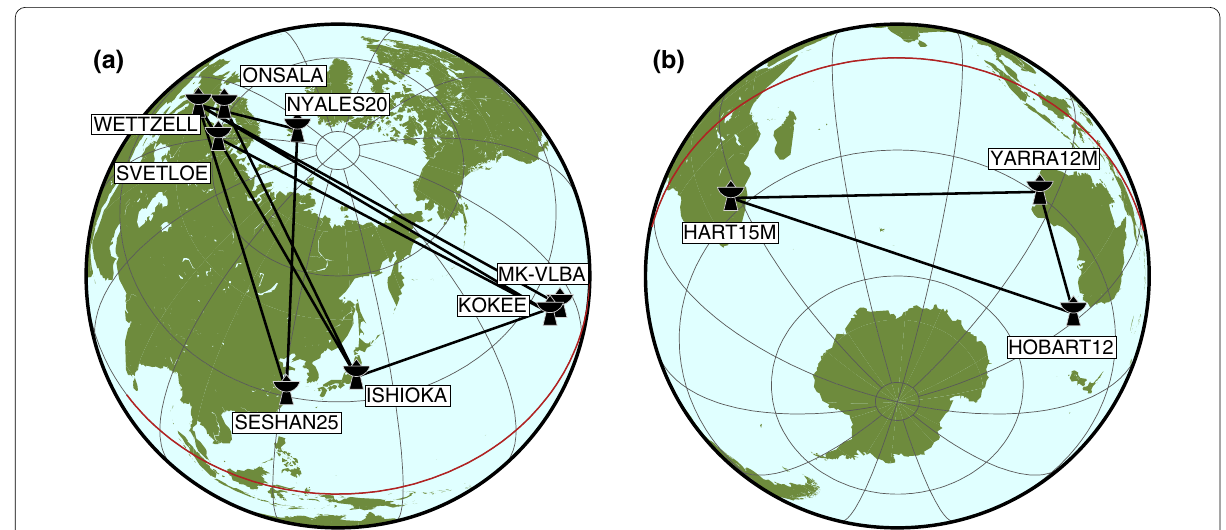
Fig. 1 Stations and baselines of INT sessions. a Northern hemisphere configurations typically involved in IVS INT sessions. b Network of the SI